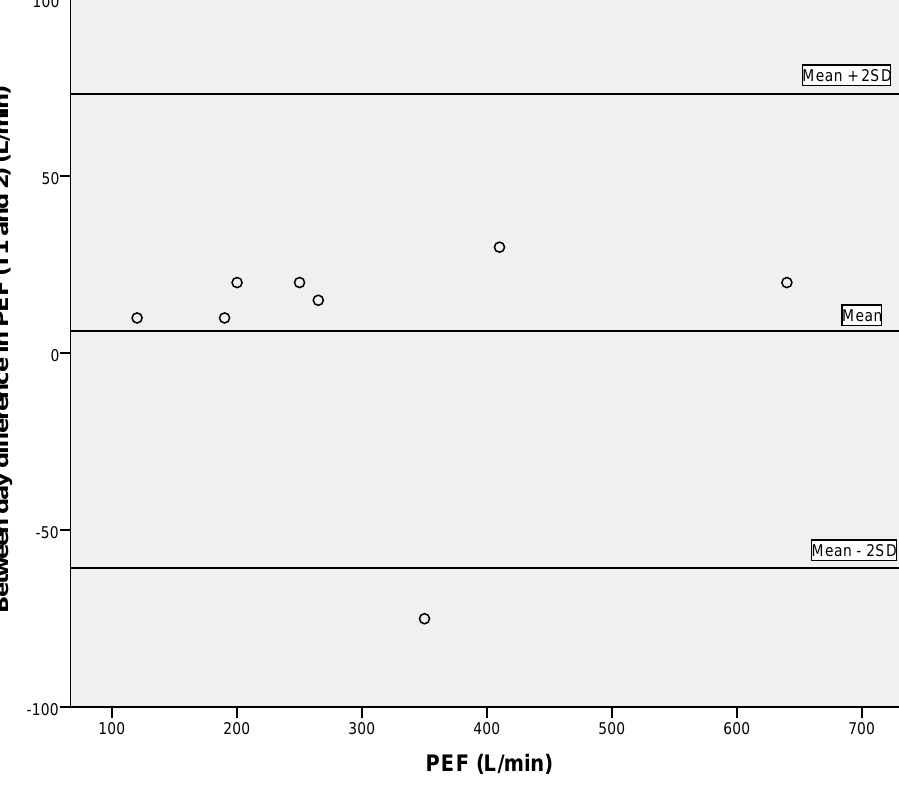
Figure 2. Bland–Altman plot showing between day variation for